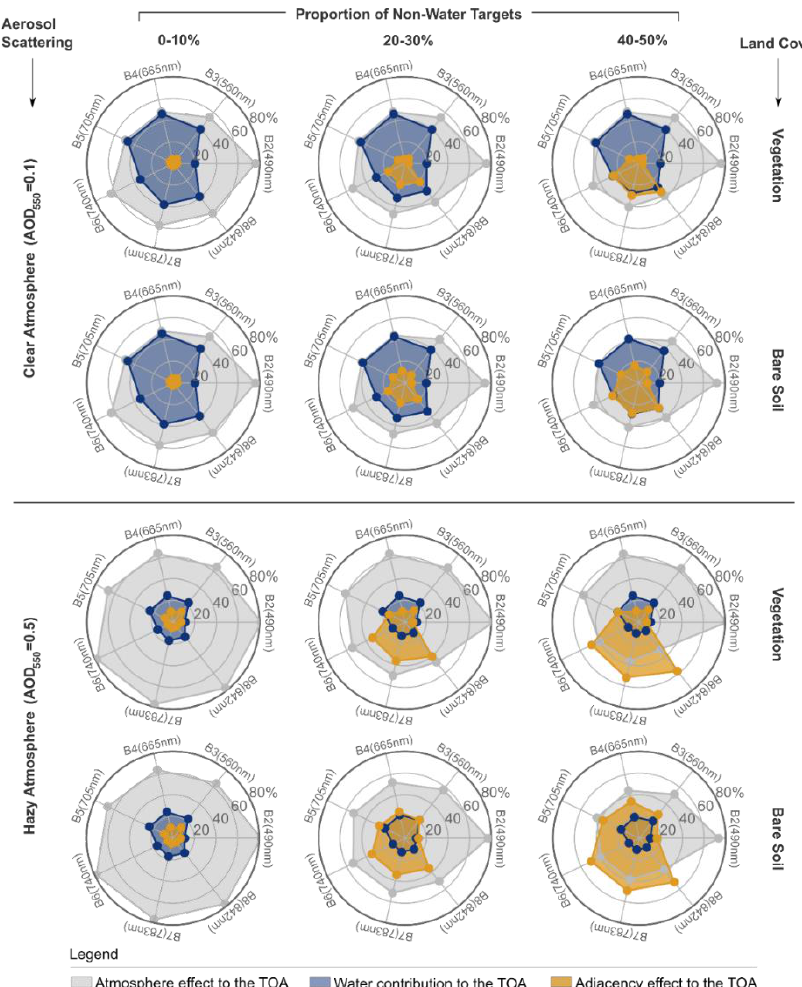
⁄ in %) along visible and Figure 11. Values of adjacency effect contribution at the TOA ( ρ ρ ρ adj TOA adj / TOA in %) along visible and